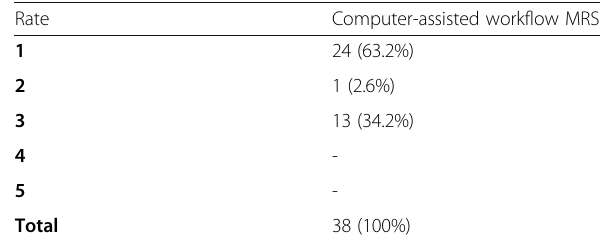
Table 5 Results of automatic prostate segmentation by DOT engine MRS